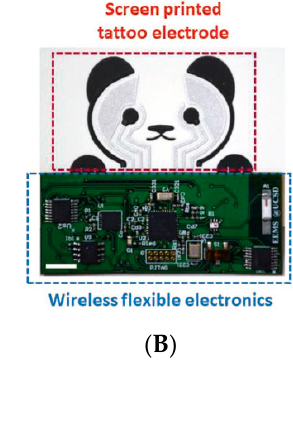
( D ) Top: Picture of a flexible sweat extraction and sensing device along with the data-treatment electronics on a flexible board. Bottom: iontophoresis and sensing mode of operation. Reproduced from [38] with permission. Copyright 2017, National Academy of Sciences.